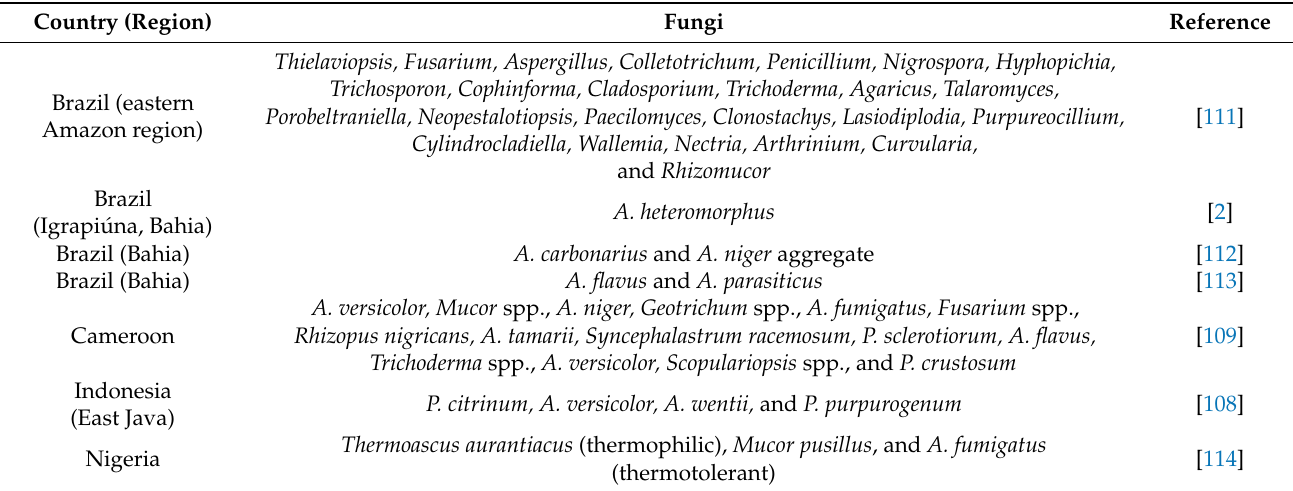
Table 1. Fungi reported in stage fermentation, classified by